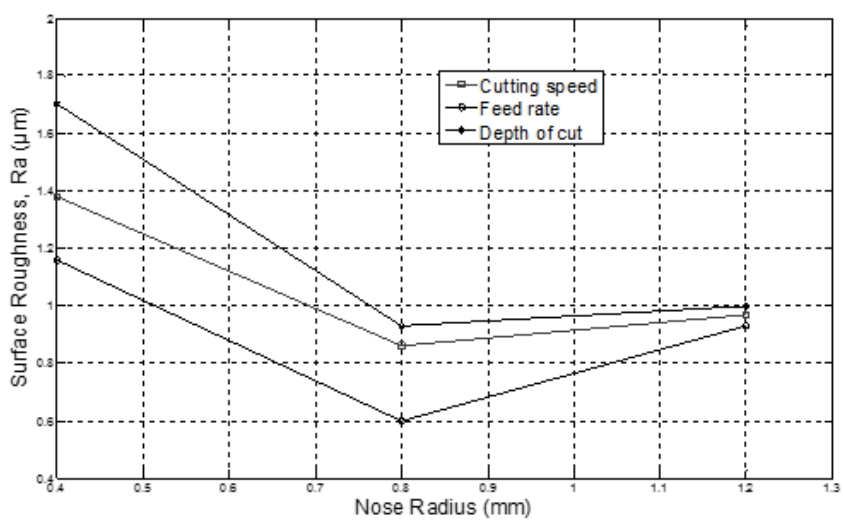
Figure 7: Influence of nose radius on surface